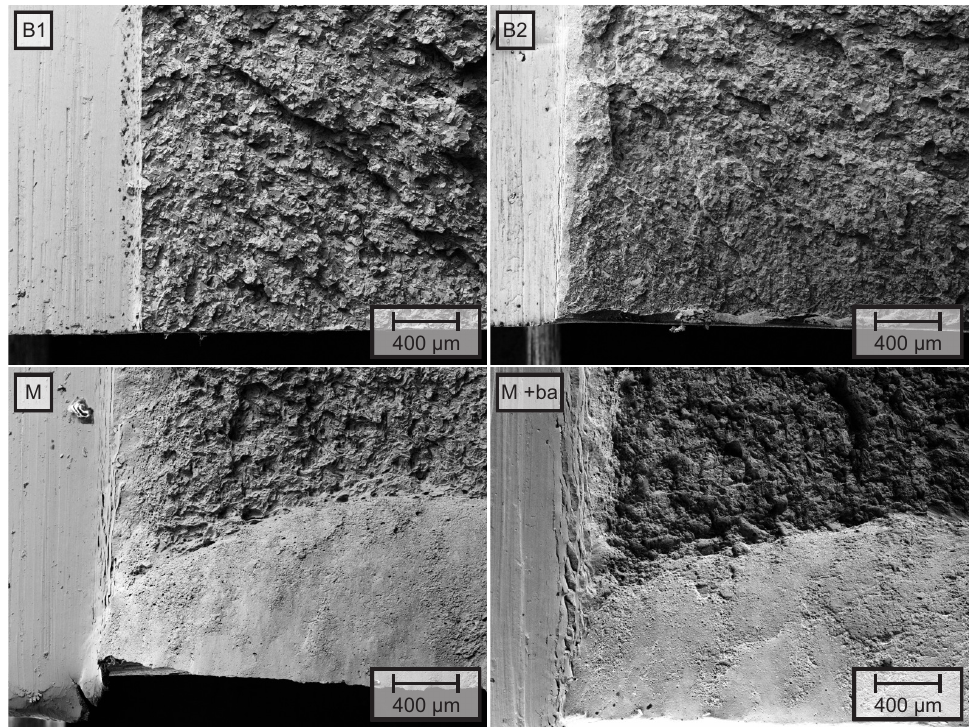
Figure 8. Fracture surface of Charpy V-notch impact test samples: Overview of the different overall fracture morphology, with the notch visible on the left edge of the image.